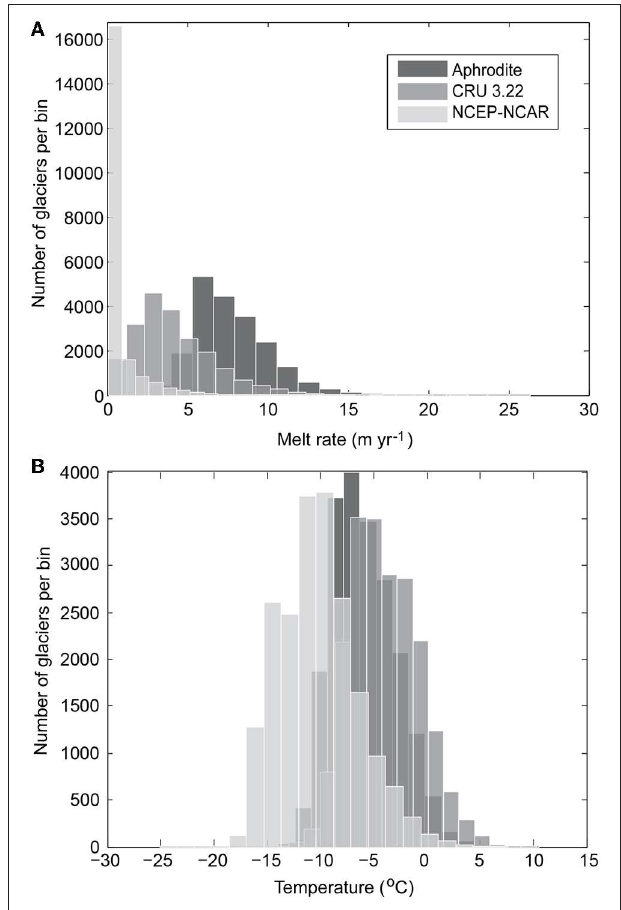
FIGURE 7 | Histograms of (A) glacier melt rate and (B) temperature for three climate datasets: APHRODITE (dark gray), CRU (intermediate gray), and NCEP (lightest gray). Note that all three melt-rate histograms are right-skewed while temperatures show a Gaussian distribution. As temperatures decrease, the median melt rates shift to lower values, resulting in an increasing number of glaciers binned into the zero melt rate (as seen with NCEP here). This leads to a significant number of glaciers not contributing to the total meltwater flux when using NCEP temperature data as compared to APHRODITE and